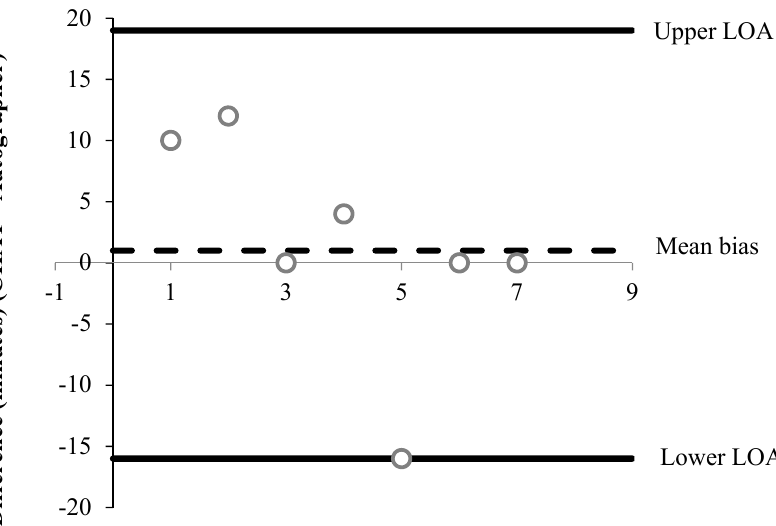
Figure 6. Bland–Altman plot demonstrating the difference between self-reported and autographer- derived homework and reading duration after school ( n = 7). A mean bias of +1 min ( ± 9 min) with LOA of +19 and − 16 min is shown.